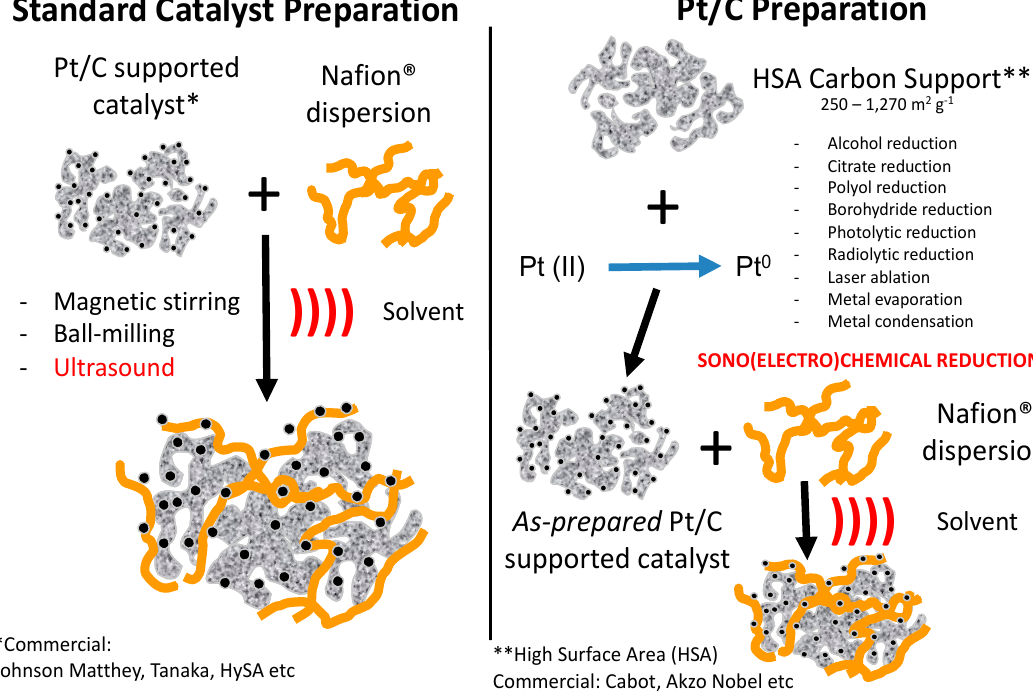
Figure 12. Various routes for preparing PEMFC, DMFC, and PEMWE catalyst ‘inks’.